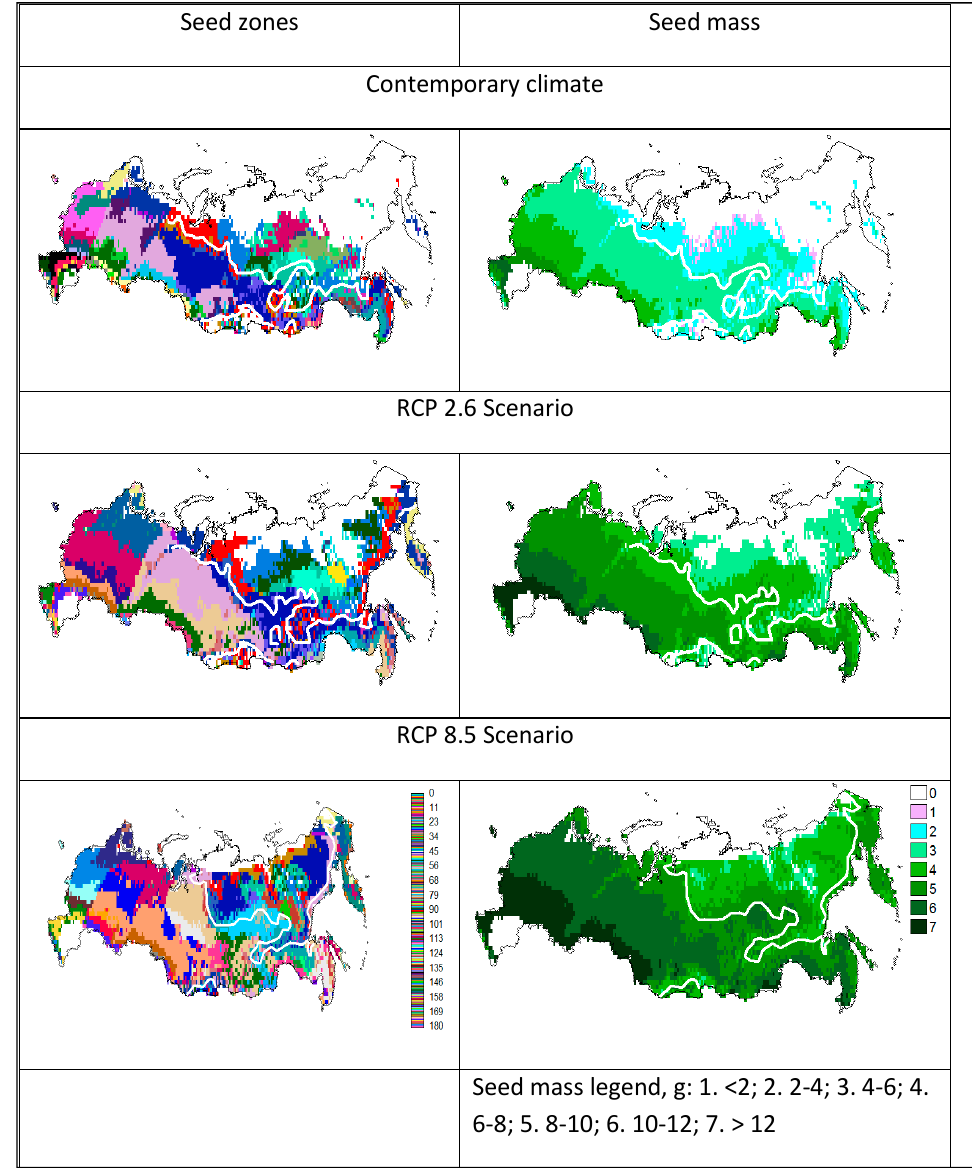
Figure 3. Distributions of potential seed zones ( Left ) and seed mass ( Right ) across Russia in con- temporary climate (Upper) and future RCP 2.6 (Middle) and RCP 8.5 (Lower) climates by 2080. The white line is the permafrost border that divides the realized (below the border) and non-realized (above the border) seed zones with the corresponding seed mass. Seed zone legend see Table 1.